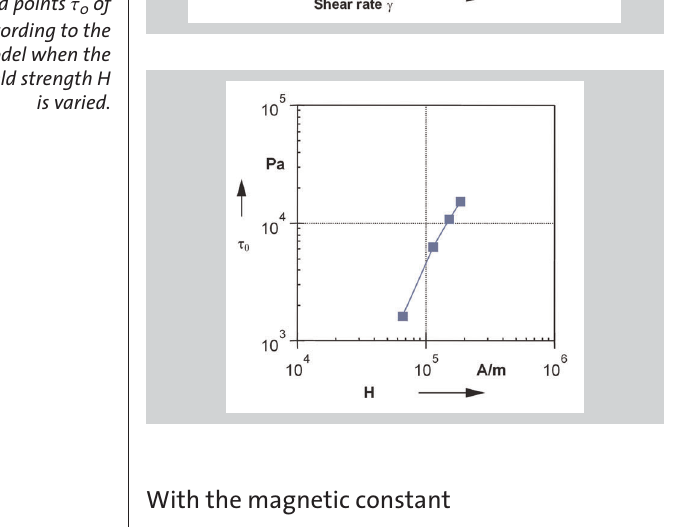
Figure 3 (left aboove): Flow and viscosity curve of the MRF-HV without an external magnetic field H = 0 A/m. Figure 4 (right above): Flow curves of MRF-HV with increasing magnetic field strength H. Figure 5 (left below): Apparent yield points t 0 of MRF-HV according to the Bingham model when the magnetic field strength H is varied.